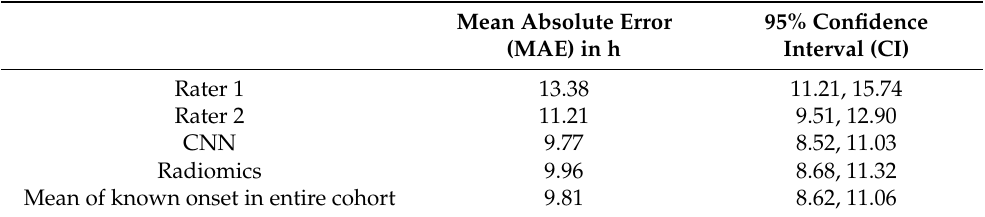
Table 1. Results of human raters and machine learning classifiers for onset estimation of patients with intracerebral